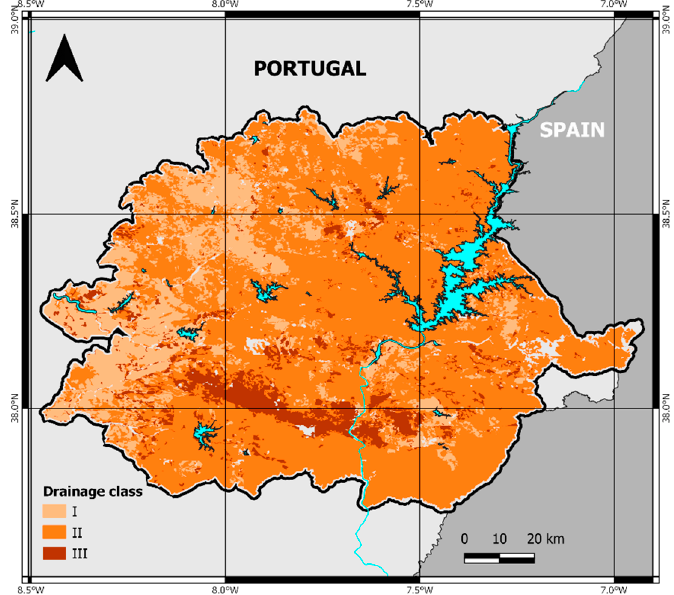
Figure 4. Drainage classes of the study area. I—Good; II—Moderate; III—Restricted.